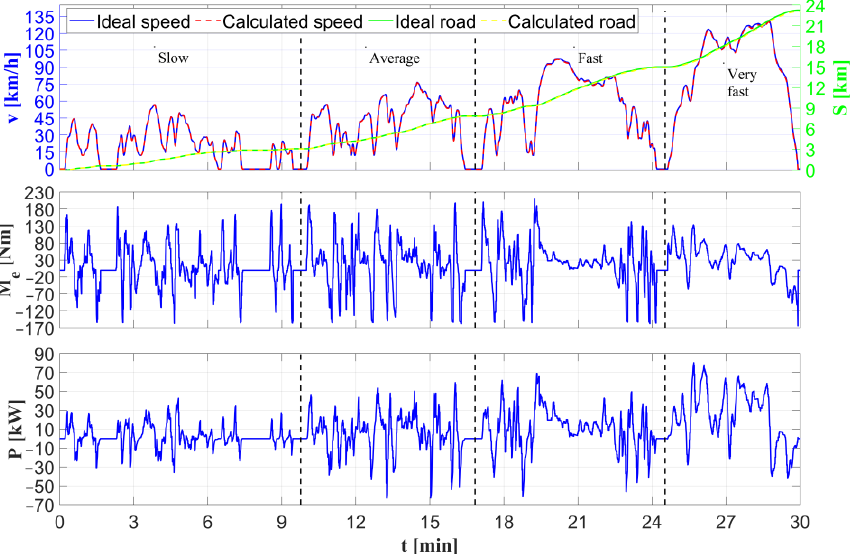
Figure 16. WLTP driving cycle for 2 × 146 kW IPMSM in EV.